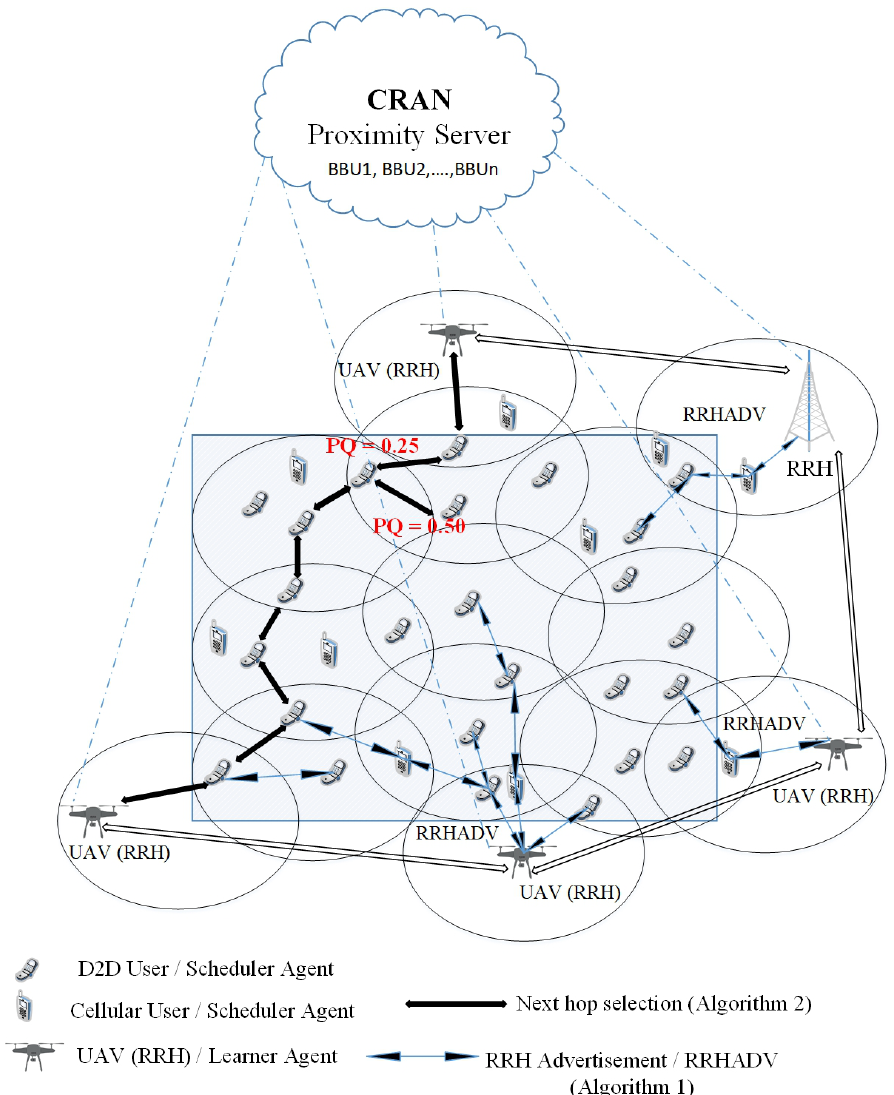
Figure 3. Illustration for Algorithm 1 and Algorithm 2. Algorithm 1: Remote radio head (RRH) advertisement (RRHADV) from RRHs. Scheduler agents/user equipment (UEs) receive RRHADV